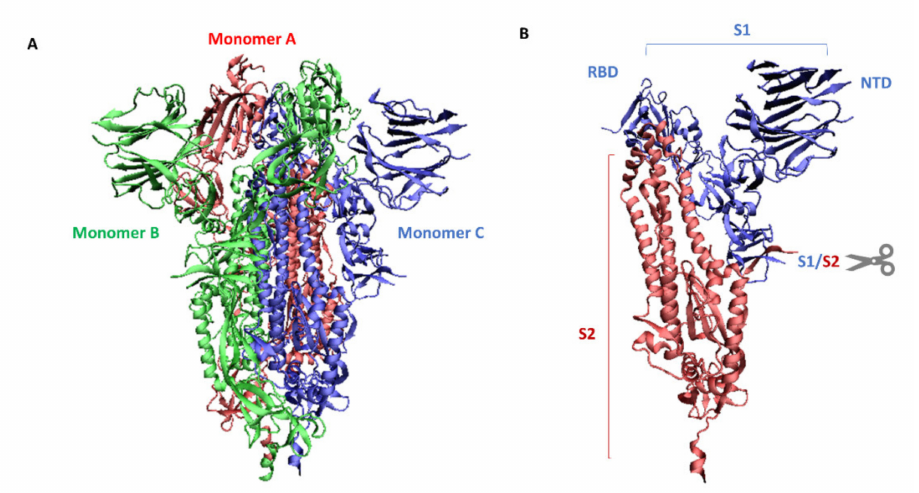
Figure 2. Structure of the SARS-CoV-2 spike protein (PDB: 6VXX). ( A ) The S protein has a trimeric structure and its three monomers are colored in red, green, and blue. ( B ) Each monomer of spike protein consists of two subunits, S1 and S2. S1 subunit has two domains: RBD—receptor-binding domain and NTD—N-terminal domain. RBD domain is responsible for recognizing and binding to the angiotensin-converting enzyme 2 (ACE2) receptor on the host cell surface; NTD domain is involved in the initial binding of the virus to cells. Cleavage of S1/S2 dimer by TMPRSS2 (transmembrane serine protease 2) activates spike protein leading to the host cell